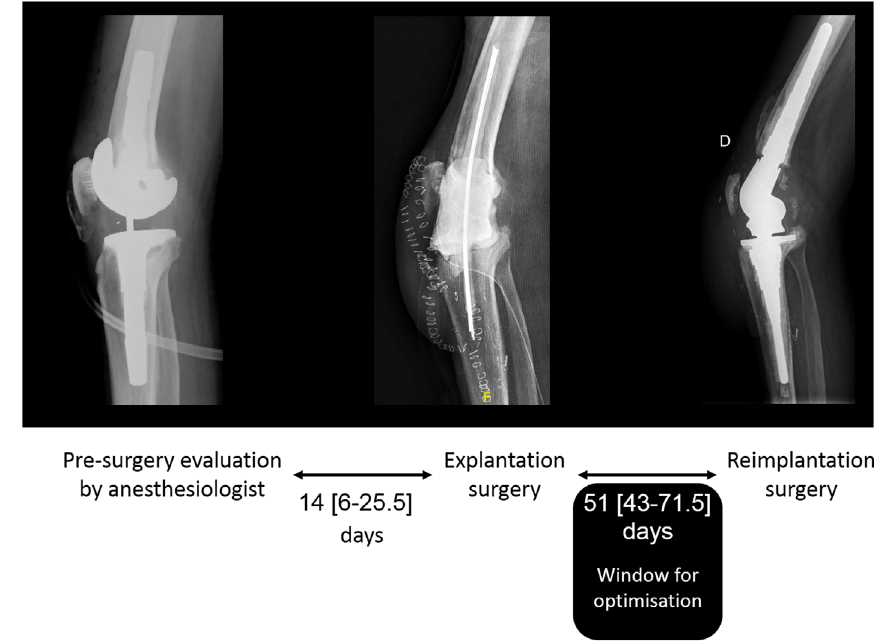
Figure 1. Analysing the large time-frame in fl uencing window to optimize the patient for the